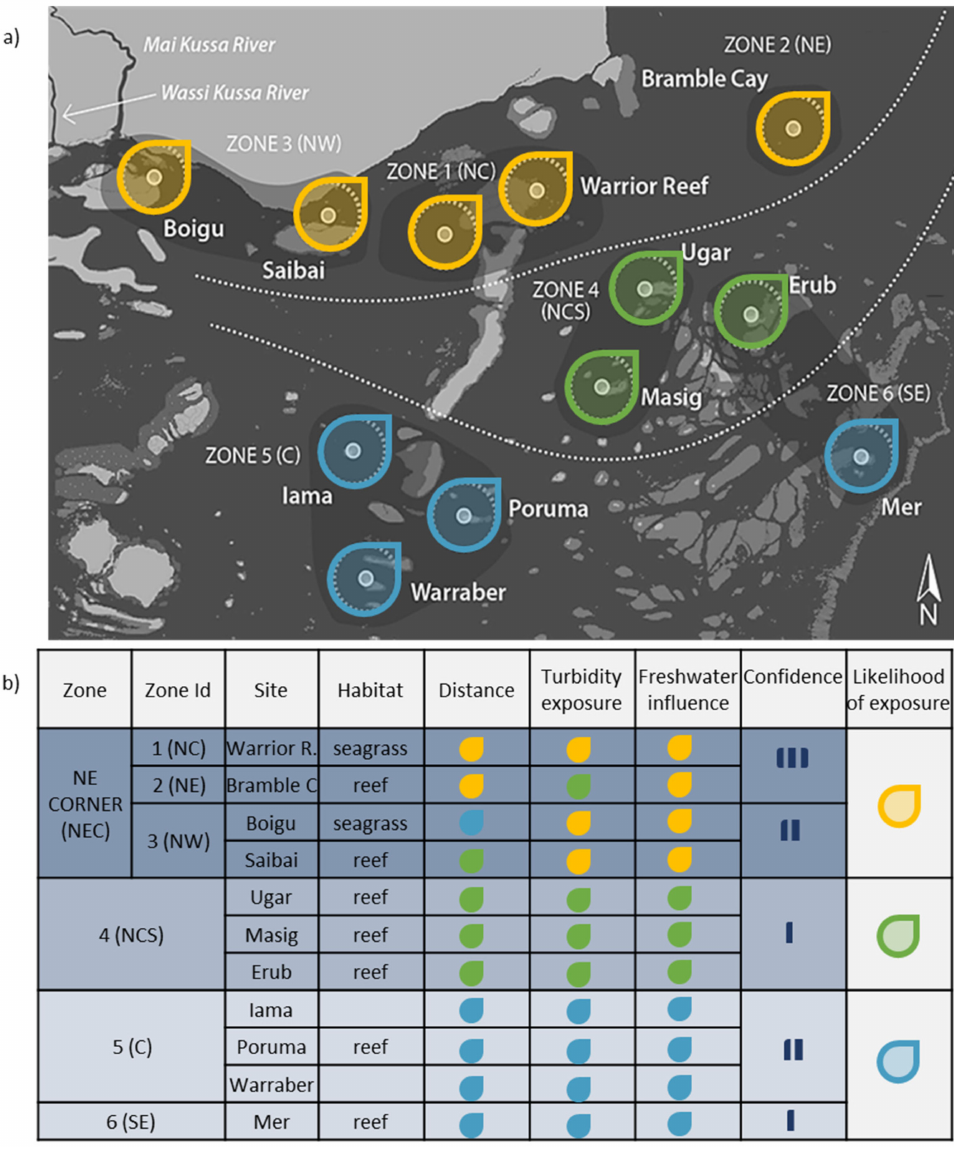
Figure 9. Quantitative assessment of the relative likelihood of exposure to Fly River discharge and/or derived sediments. ( a ) Map illustrating the different zones from the assessment, including the North-East Corner (NEC, zones 1 to 3), the North Central–South area (NSC, zone 4), the Central (C, zone 5) and the South-East (SE, zone 6) zones. ( b ) Table summarizing the sites and major habitats in each zone, the relative scores given to the three indicators used in the assessment: “Turbidity Exposure”, “Freshwater Influence” and “Distance”, and the final ‘likelihood of exposure’ score, where yellow-green–blue, indicate higher to lower relative